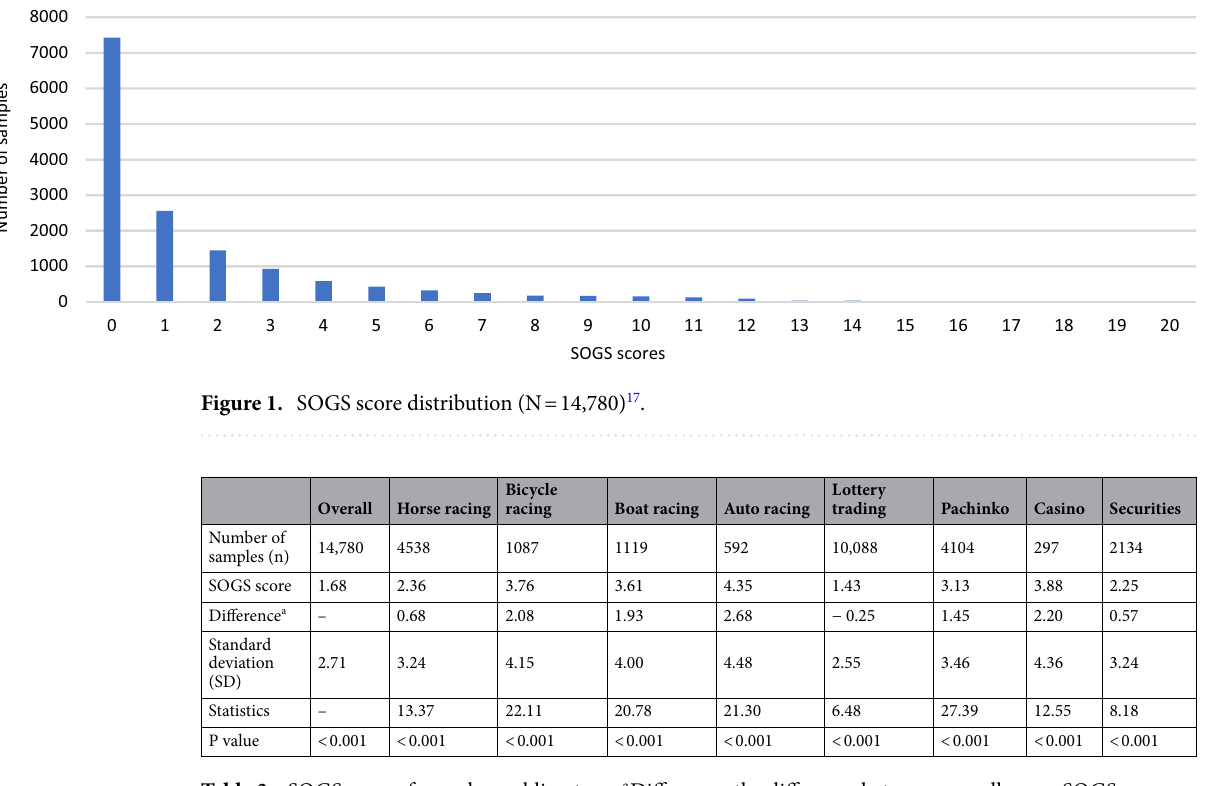
Table 3. SOGS scores for each gambling type. a Difference: the difference between overall mean SOGS score and mean SOGS score for each gambling type. Standard deviation, statistic, and p-value are from the difference test.